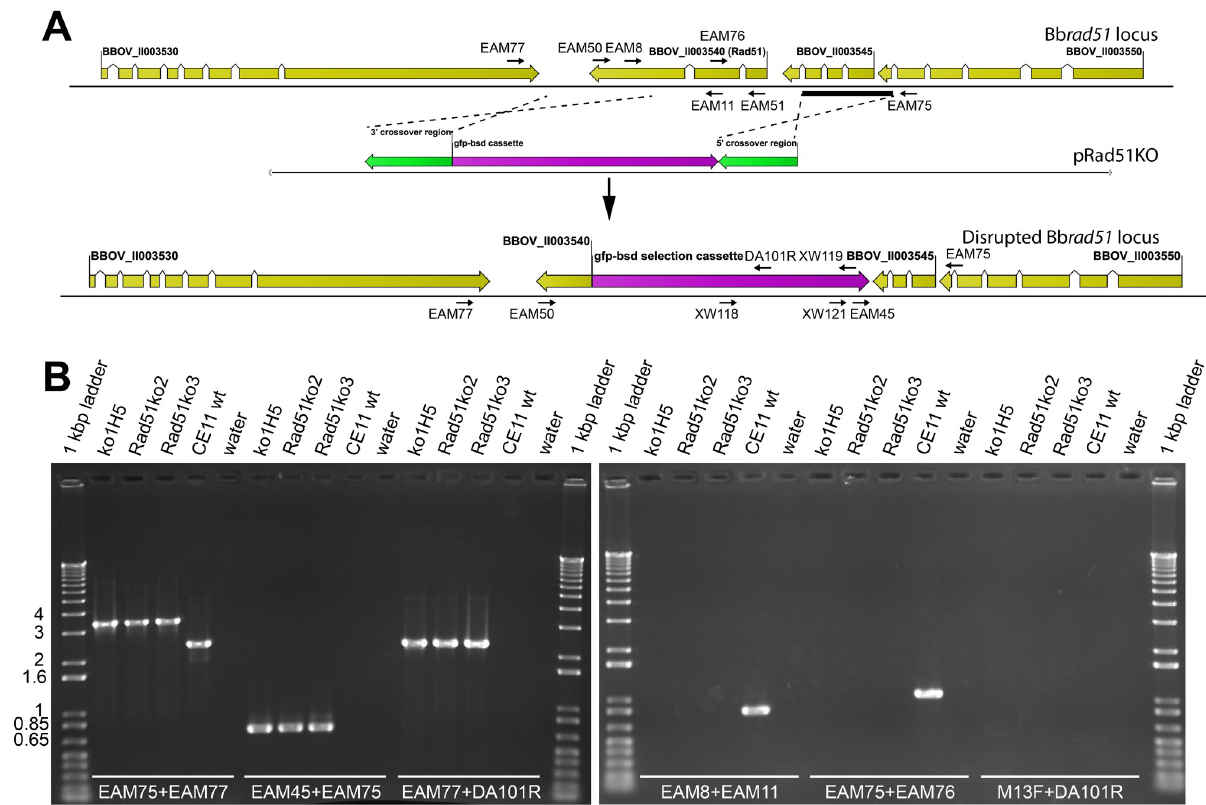
Fig 2. Bb rad51 locus and knock-out strategy. A. The wt Bb rad51 locus structure was confirmed to be comprised of three exons/ two introns. The gene was replaced by double homologous crossover, with a selectable gfp-bsd cassette (purple arrow) driven by the B . bovis EF1 α -B hemi-promoter [10, 14], using flanking sequences from the locus (crossover regions shown as green arrows). The structures of the Bb rad51 wt locus (top), pRAD51KO plasmid (center), and the disrupted Bb rad51 locus (bottom) are shown. Primers used in PCR reactions and Southern blotting (S2 Table), and the sites to which each anneals, are indicated. B. Diagnostic PCR was used to initially confirm Bb rad51 knock-out in each line, using the primer pairs indicated. Locus structure was fully confirmed for the ko1 H5 mutant line (lanes ko1 H5), using PCR, Southern blotting and sequencing. Bb rad51 knock-out was supported by diagnostic PCR for CE11 Δ rad51 ko2 and CE11 Δ rad51 ko3 (lanes Rad51 ko2 and Rad51 ko3 , respectively).